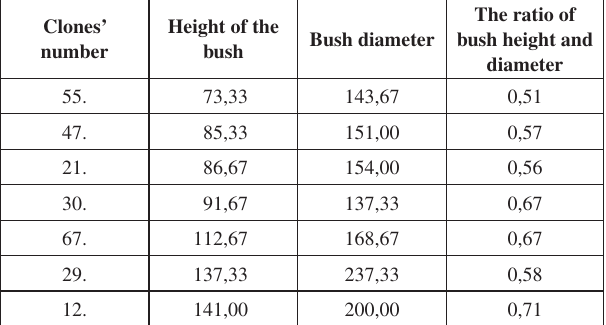
Table 4. Bush size parameters and the calculated ratio of bush height and diameter in a two-year-old Lycium orchard, in 2011.